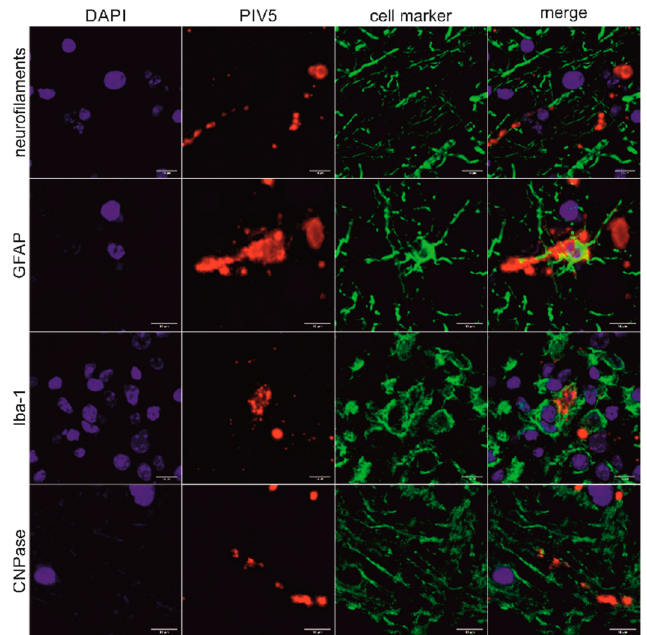
Figure 4. Correlation of PIV5 RNA with different brain cell types in animal 26731. Combination of fluorescent in situ hybridization (ISH) using the PIV5 RNAscope probe with immunofluorescence (IF) using different cell markers of the midbrain of animal 26731. The cell markers used were neurofilaments clone 2F11, glial fibrillary acidic protein (GFAP), ionized calcium-binding adapter molecule 1 (Iba-1), and 2 ′ ,3 ′ -cyclic-nucleotide 3 ′ -phosphodiesterase clone 11-5B (CNPase). Nuclei were stained in blue, PIV5 RNA was stained in red, and different cell markers were stained in green. A clear association of PIV5 RNA with axons, astrocytes, microglia, and myelin sheaths can be seen. Scale bars: 10 µm.